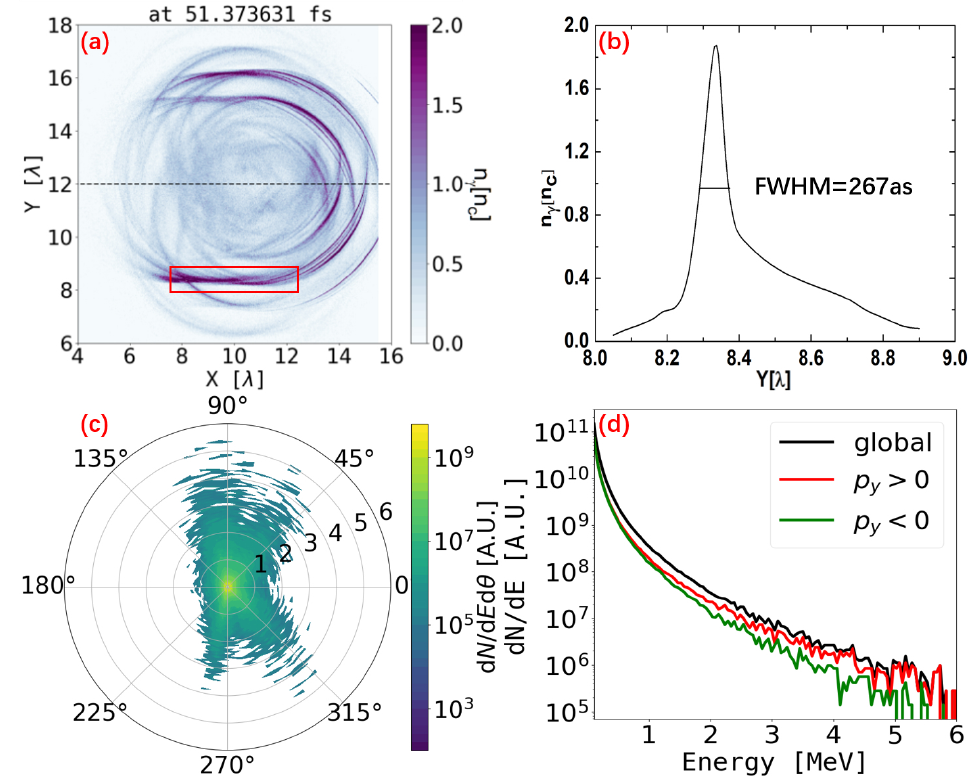
Figure 4. (Color online). ( a ) The density distribution of photons at 19.24 T 0 . There are three bunches of photons around y = 8.3 λ 0 , y = 15.15 λ 0 and y = 16.15 λ 0 . ( b ) The density distribution of photons around y = 8.3 λ 0 ; the FWHM is 0.1 T 0 (267as). ( c ) The angular distribution of photons; the unit of radial scale is MeV. ( d ) The energy spectrum of photons; the cut-off energy is 6 MeV. p y > 0 corresponds to the red curve, p y < 0 corresponds to the green curve and the total momentum corresponds to the black